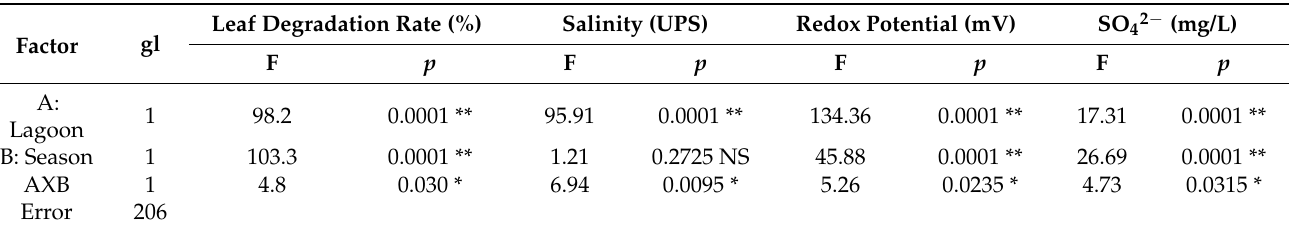
Table 1. Two-way ANOVA of leaf degradation rate (%), chemical parameters in two mangrove forests bordering the Chacahua and Salina lagoons, Oaxaca, at two times of the year with significance